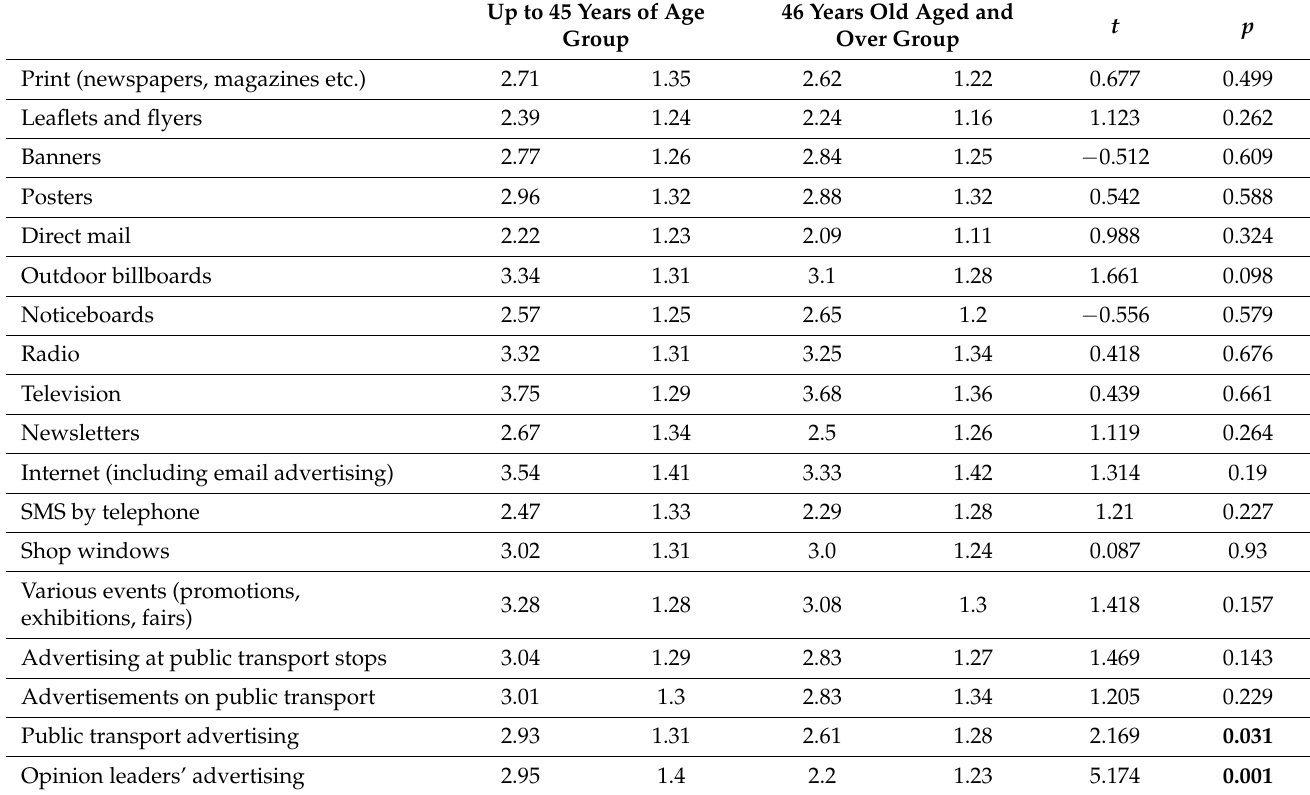
Table 8. Evaluation of the information tools and channels where advertising would most promote sustainable mobility and multimodality, for different age groups ( t -test for independent samples). Up to 45 Years of Age 46 Years Old Aged and t Group Over Group